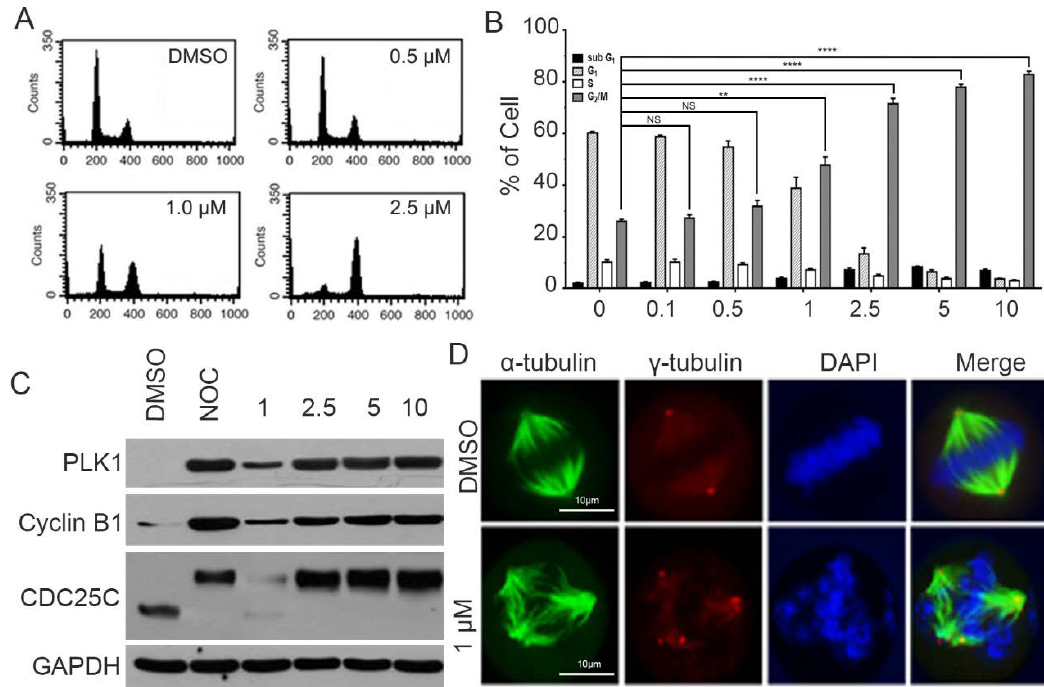
Figure 3. CPPF-induced cell cycle arrest during mitosis in HeLa cells. ( A ) HeLa cells were treated with various concentrations of CPPF for 17 h. Cells were harvested and stained with propidium iodide (PI). Cell cycle distribution was analyzed by flow cytometry; ( B ) Plots from A were analyzed to represent the percentage of cells in each phase graphically. Error bars represent means ± SD from three independent experiments, ** p -value < 0.005 and **** p -value < 0.0001. NS: Not significant; ( C ) HeLa cells were treated with DMSO (control) or various concentrations of CPPF for 17 h. Western blot data showed the accumulation of mitotic arrest marker proteins such as PLK1, cyclin B1 and cdc25c. These data are representative of three independent experiments. Nocodazole (NOC) treatment was at a concentration of 100 ng / mL; ( D ) Relative percentages of mitotic cells after CPPF treatment. Seventeen hours after treating HeLa cells with CPPF, tubulin was visualized by α -tubulin (green) staining and the centrosome was visualized by γ - tubulin (red) staining. DNA was stained using Hoechst 33342 (blue). Images were captured by a Zeiss microscope.